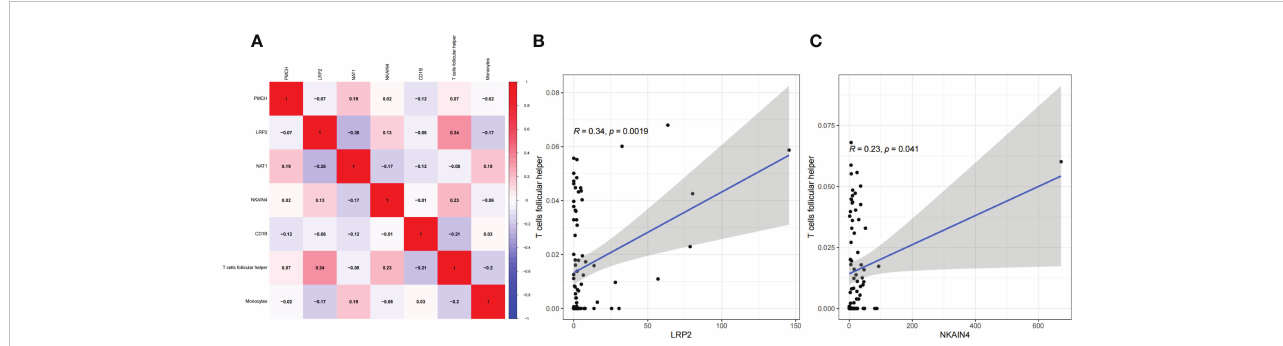
FIGURE 5 Coexpression analysis. The results of the correlation analysis of LNM-related genes expression and immune in fi ltrating cell are shown as a heatmap (A) . The correlations between LRP2 and T follicular helper cells, and NKAIN4 and T follicular helper cells (B, C) ; LNM,lymph node